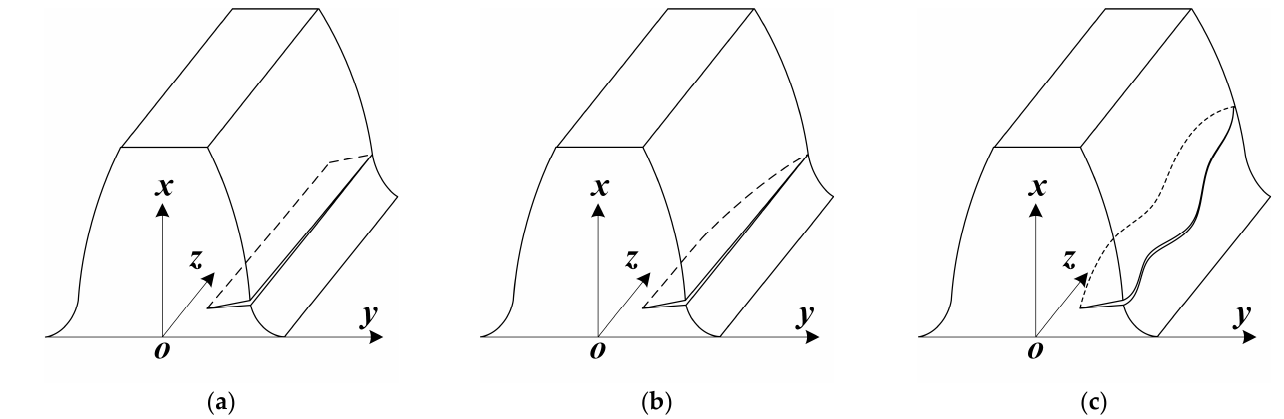
Figure 1. Different types of tooth cracks: ( a ) plane uniform crack; ( b ) plane non-uniform crack; ( c ) spatial crack.